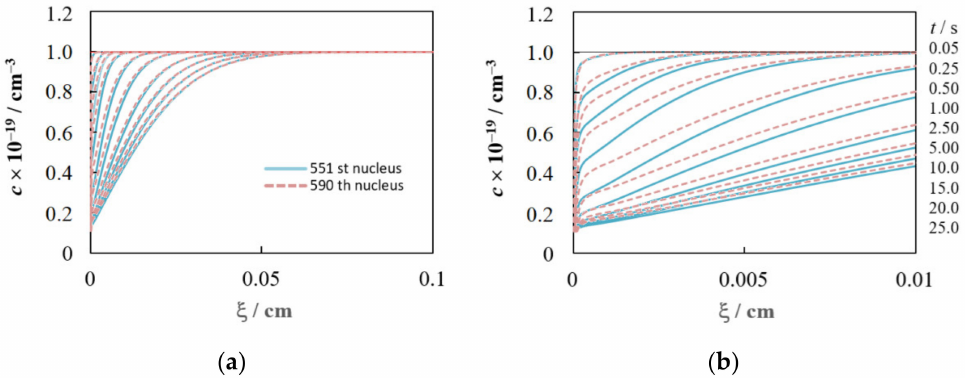
Figure 6. Concentration profiles of 551st ( S V = 7.06 × 10 − 7 cm 2 , R V = 2.95 × 10 − 4 cm) and 590th ( S V = 8.77 × 10 − 7 cm 2 , R V = 4.89 × 10 − 5 cm) nuclei (see Figure 2a) at the times indicated on the right; ( a , b ) differ only in ξ scale. η = 100 mV. Values for other parameters are specified in Section